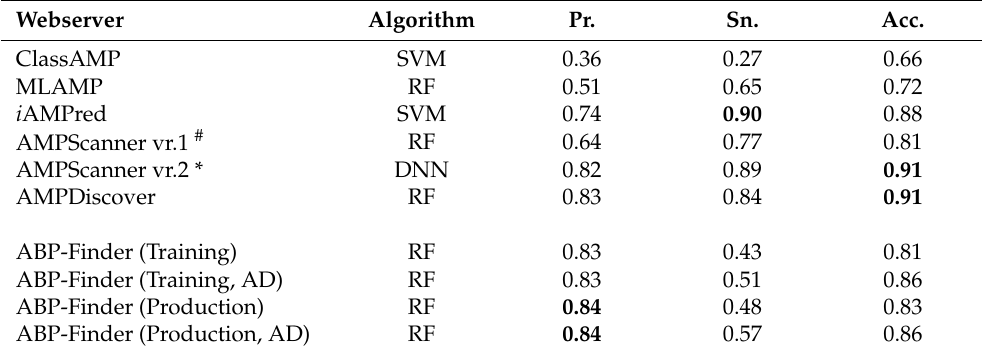
Table 4. Comparison with external predictors in the test set built by Veltri et al. [30]. Redundant instances with our training set were removed. The values in bold denote the best performance for a given measure.